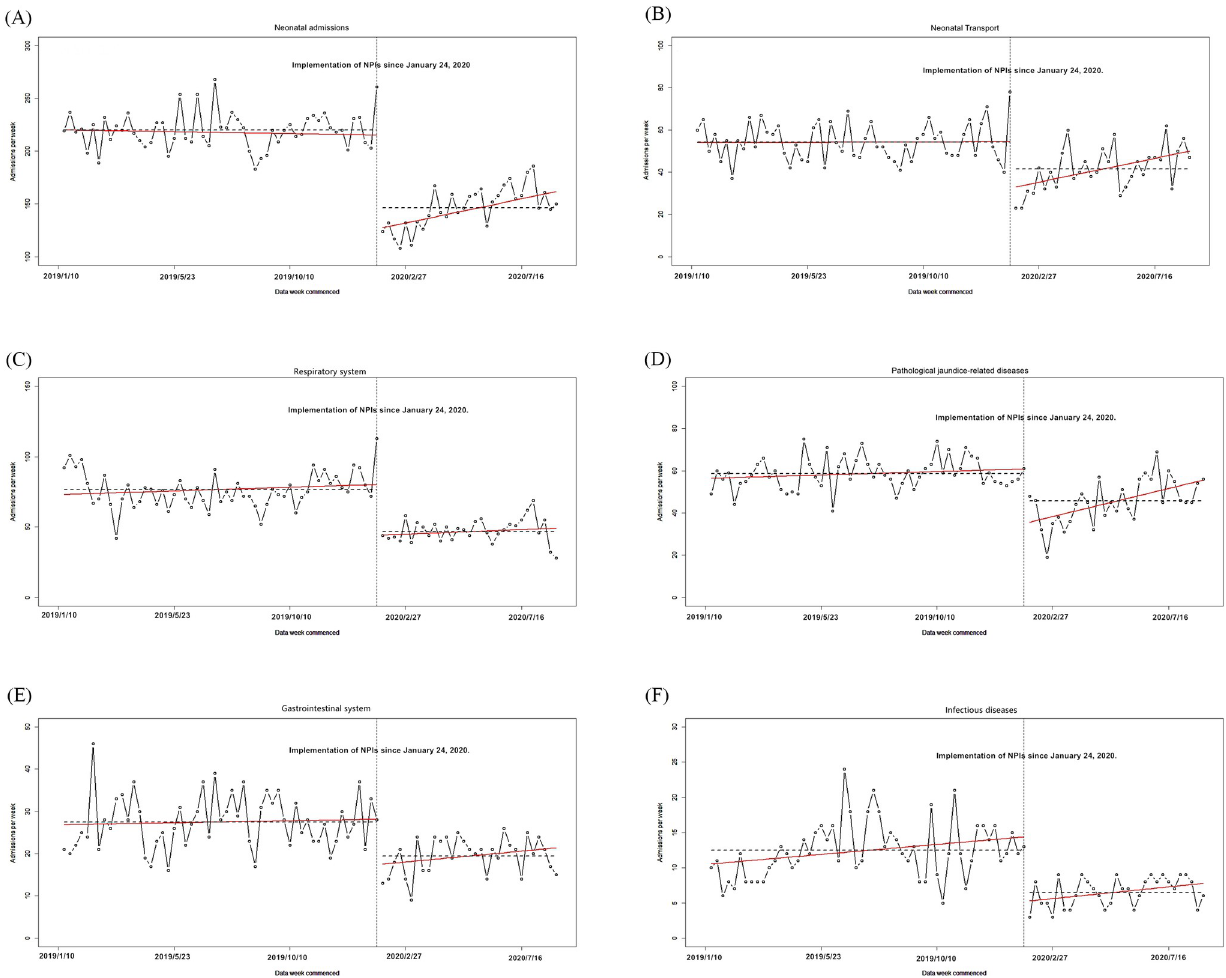
Fig 2. Impact of interventions on attendances and disease spectra based on segmented regression analysis. (A) Neonatal admissions (B) Neonatal Transport (C) Respiratory system (D) Pathological jaundice-related disease (E) Gastrointestinal system (F) Infectious diseases.The black points in the plot represent weekly changes in the volume of attendances and disease spectra. The red fitted lines are from Prais-Winsten estimates. Dashed horizontal lines indicate the level change.